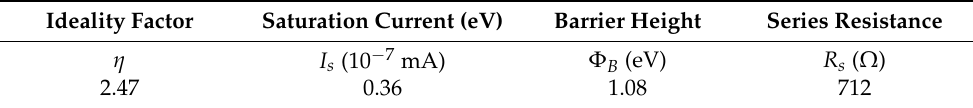
Table 1. Diode parameters were obtained by fitting the experimental I vs. V curve. Ideality